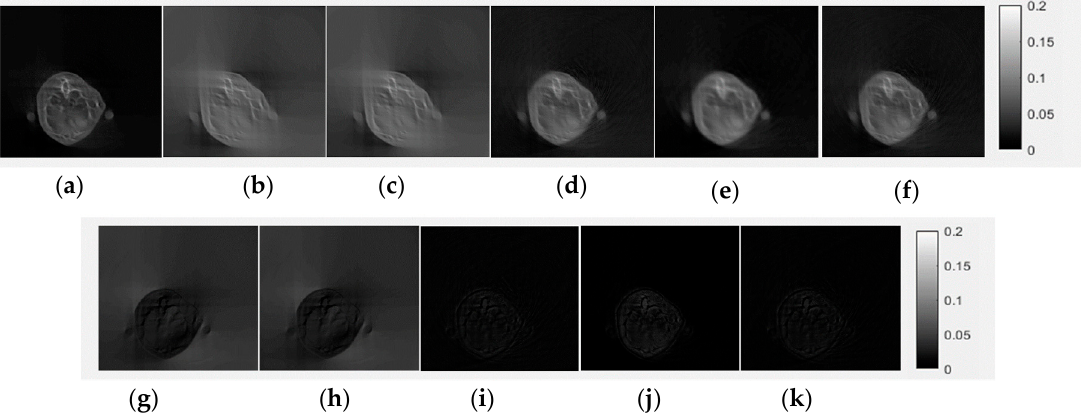
Figure 5. Evaluation of the completed LA sinogram results from the sinograms and their reconstructed images. ( a ) True sinogram, ( b ) Simulated LA sinogram and ( c ) CE inpainted sinogram from the testing set. ( d ) The difference of the sinogram ( a ) subtracted by ( b ) and ( e ) is the difference of the sinogram ( a ) subtracted by ( a ) and ( c ).